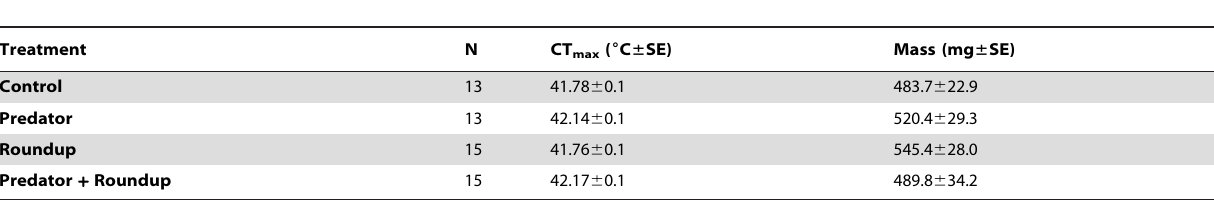
Table 1. Critical thermal maximum (CT max ), sample size (N) and body mass (Mass) of Hyla versicolor tadpoles, in four treatments.